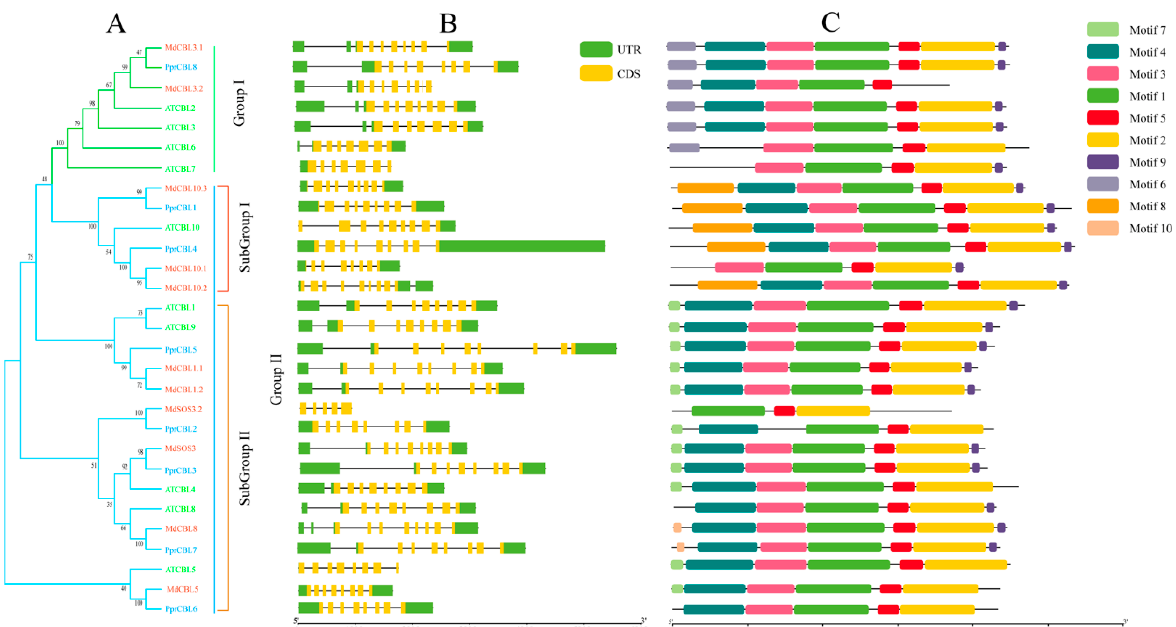
Figure 1. Phylogenetic, structure and motif analysis of CBL gene families from peach, Arabidopsis and apple. ( A ) The phylogenetic analysis of CBL; different colored arcs represent different subgroups. Prefixes ‘Ppr’, ‘Md’ and ‘At’ indicate CBL proteins from Prunus persica, Malus domestica and Arabidopsis, respectively. ( B ) The gene structure analysis of the CBL members; the green rectangle represents the untranslated region (UTR), and the yellow rectangle represents the coding sequence (CDS). ( C ) The conserved motif analysis of each CBL member and different colored rectangles represent different motifs.